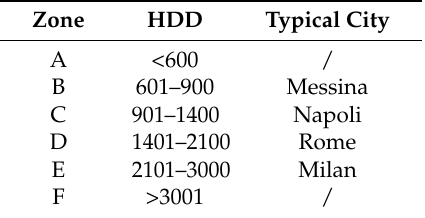
Table 1. Classification of the climate zones.